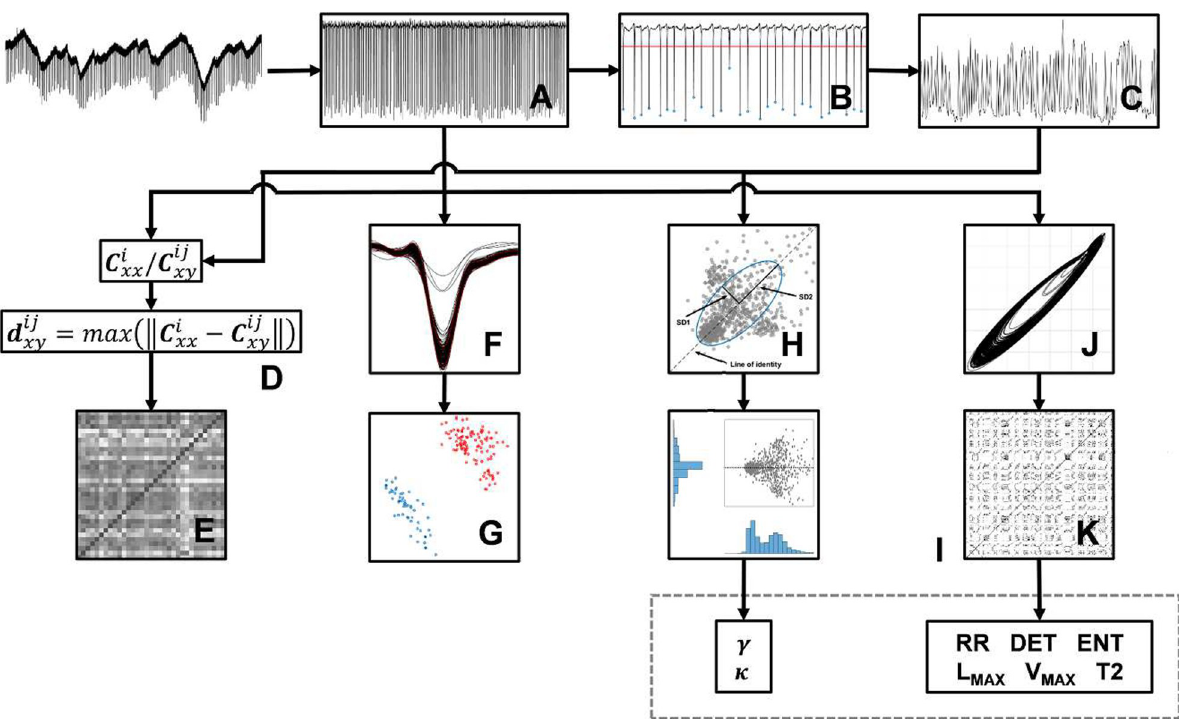
Fig 1. General scheme of the methodology. (A) The analysis started with raw data filtering for 60 Hz and harmonics removal. (B) Next, we did an automatic event-spikes detection, considering a threshold of 0.1mV and (C) calculated the interspike intervals T n (in seconds). (D) For the correlation analysis, we calculated the autocorrelation and cross-correlation from the time series in (A) and (C). (E) Next, we calculated the distance d ij autocorrelation C xx and cross-correlation C xy by Kolmogorov-Smirnov test statistic, obtaining two square matrices, one from time series in (A) and another from time series in (C). (F) To sort the waveforms, we applied a centralization into all event-spikes of the electrophysiological recordings in (A), using their minimum as reference. (G) Then, we used PCA to identify clusters and comparing the correlations between the waveform morphologies of II and PIS activities. (H) To first way of nonlinear analysis, we reconstructed the Poincare´ map plotting successive intervals T n versus T ( n +1) and we fitted an ellipse to the points of the map, with its center determined by the average of the intervals. (I) Next, we evaluated the shape of the histograms distribution from the Poincare´ map points projected onto the line of identity and onto its orthogonal axis and calculated the skewness and kurtosis of these histograms. (J) Finally, before the second way of nonlinear analysis by RQA, the electrophysiological recordings in (A) were down-sampled at 1 kHz, to construct phase space for each record, (K) then the Recurrence Plot and subsequent quantification analysis was done. All phase space was reconstructed with embedding dimension m = 3 and time delay τ = 1. To RQA, was applied l of diagonal and vertical lines, respectively, and a Theiler window of width 2 ( t w =